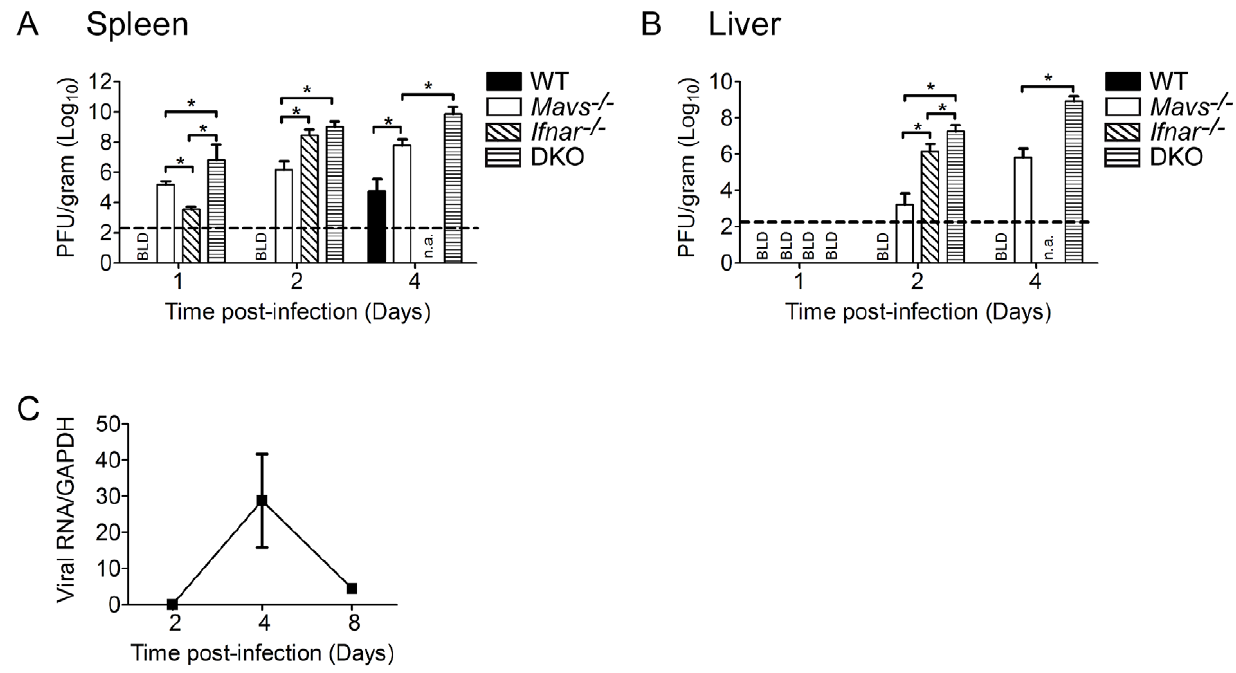
Figure 2. WNV replication in permissive and nonpermissive tissues is controlled by RLR and type I IFN signaling. Viral burden analysis of spleen (permissive) and liver (nonpermissive) tissues from WT, Mavs 2 / 2 , Ifnar 2 / 2 , and Mavs 2 / 2 6 Ifnar 2 / 2 (DKO) mice infected subcutaneously in the footpad with 100 PFU of WNV-TX. Viral burden in the ( A ) spleen and ( B ) liver were determined by plaque assay. Data are represented as PFU per gram (n=4 mice per timepoint). ( C ) Viral burden in WT infected livers determined by qRT-PCR using virus-specific primers and represented as a relative ratio of WNV to GAPDH RNA (n=3–4) mice per timepoint). Graphs show the mean + / 2 standard deviation for each measurement. Asterisk denotes P , 0.05. The horizontal line indicates the lower limit of assay sensitivity. BLD=below limit of detection. n.a.=not